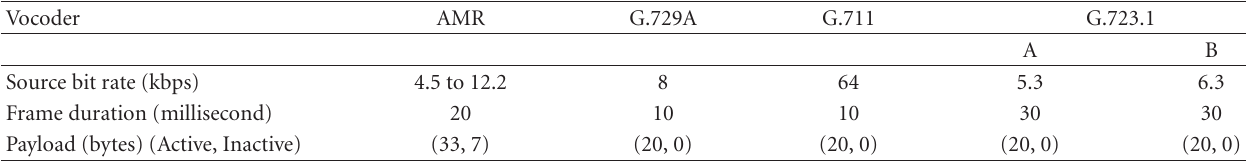
Table 5: Vocoder parameters